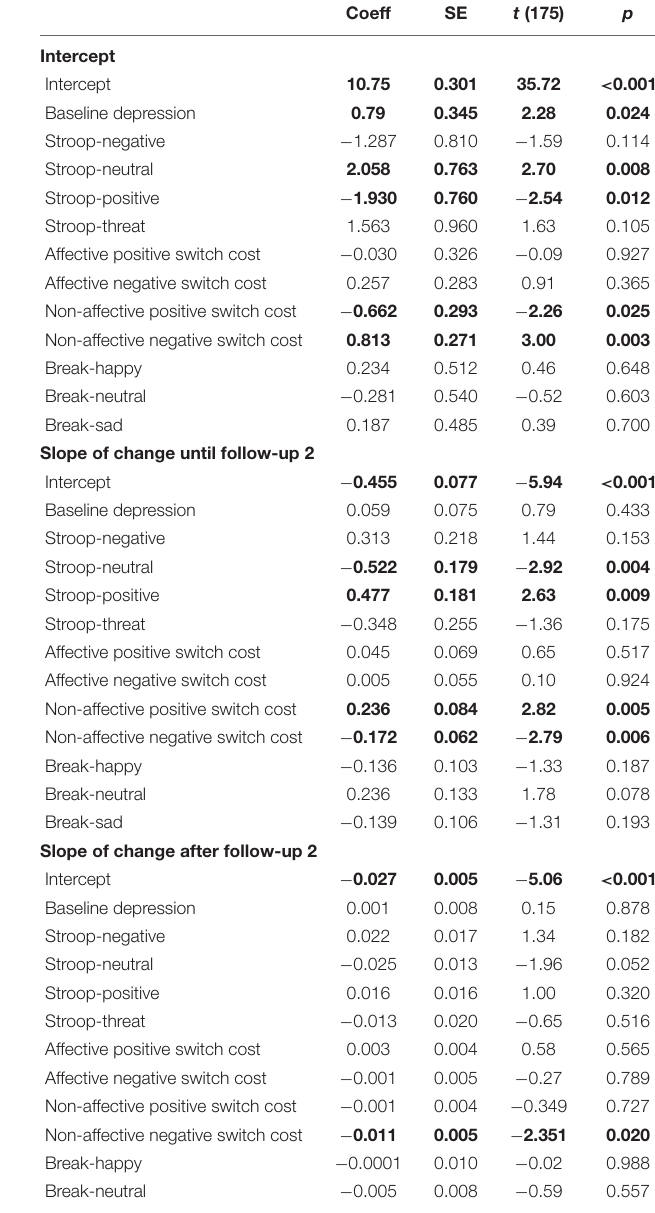
The bolded values indicate that the values are statistically